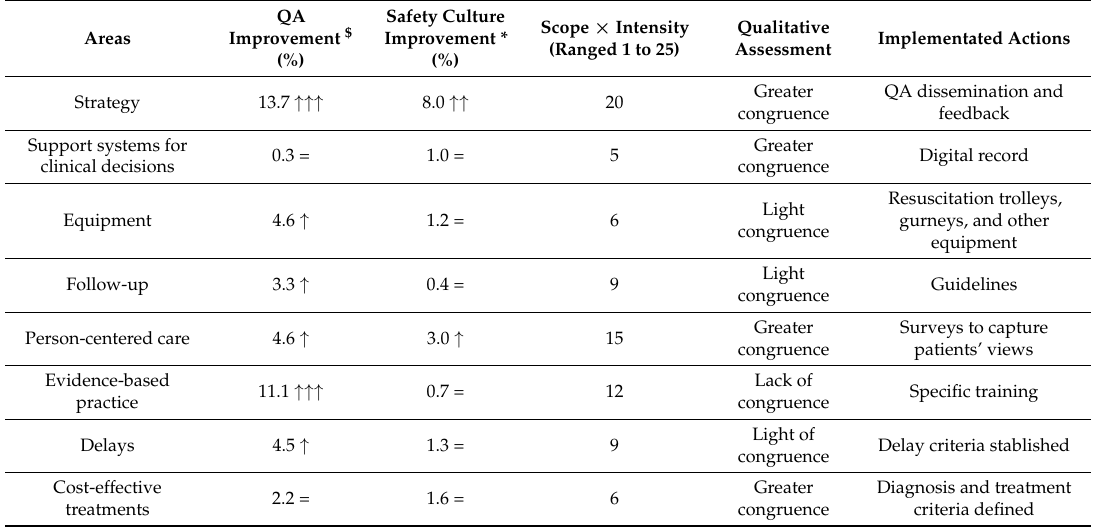
Table 2. Qualitative analysis comparison of the improvements on safety culture and quality assurance measurements and scope and intensity measures of the QA actions